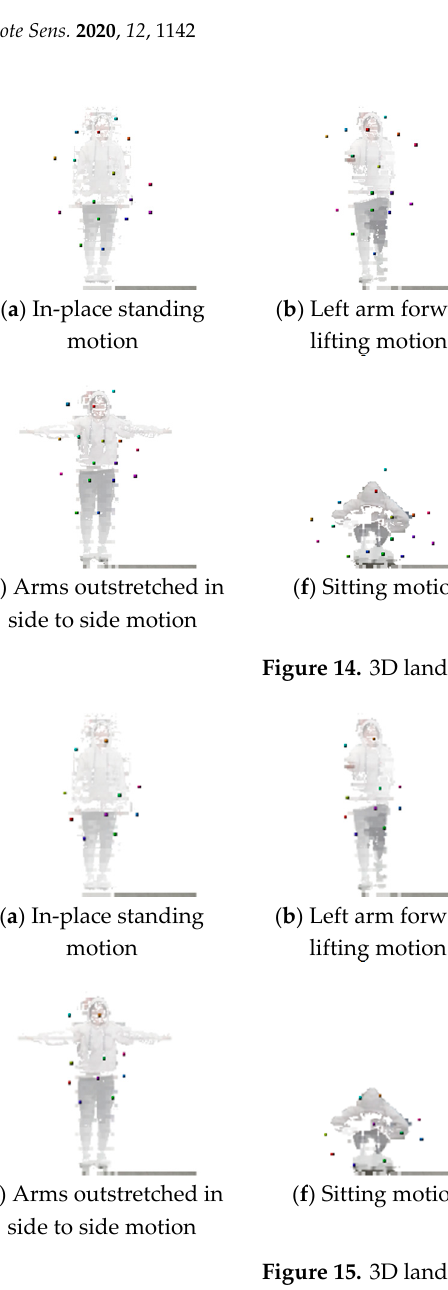
Table 2. Location of landmark extraction. RGBD image